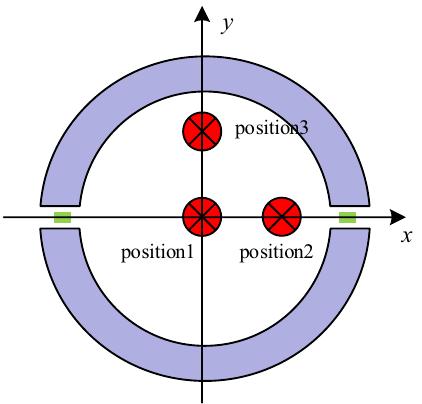
Figure 11. Diagram of three positions of electrical wine